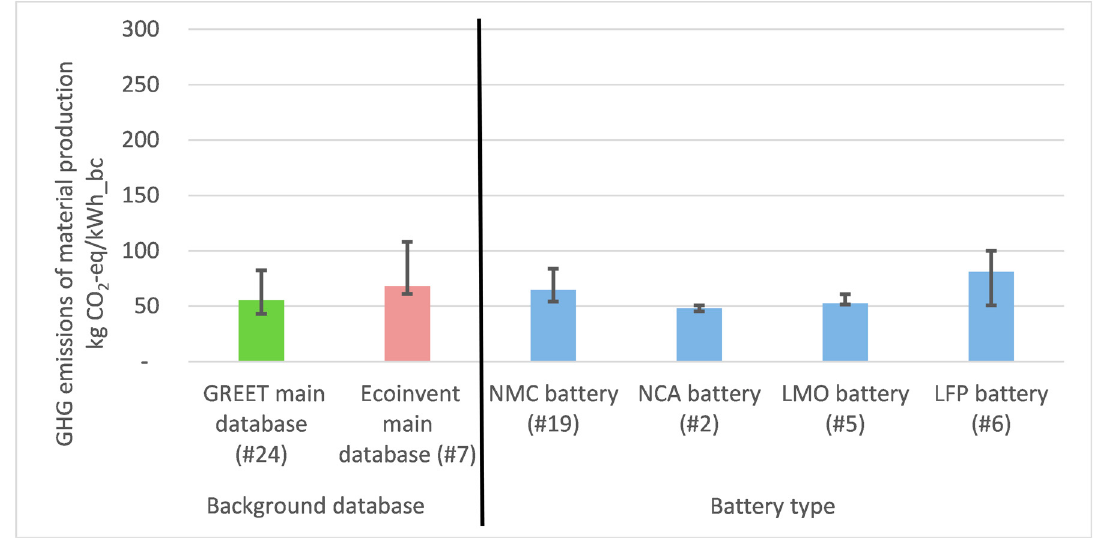
Figure 5. GHG emissions comparison of material production between background databases and battery types (results based on median, 25%-quantile, and 75%-quantile).